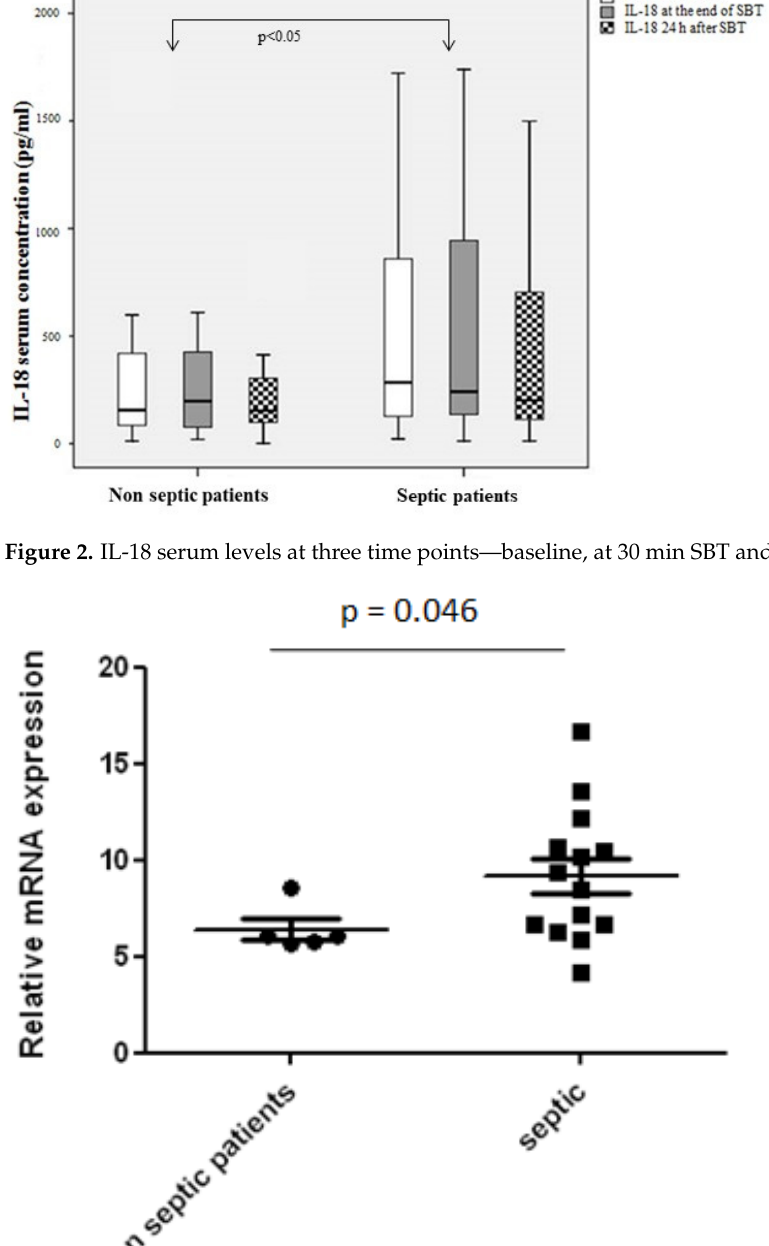
Figure 3. IL-18 mRNA expression in the serum of septic and non-septic patients.